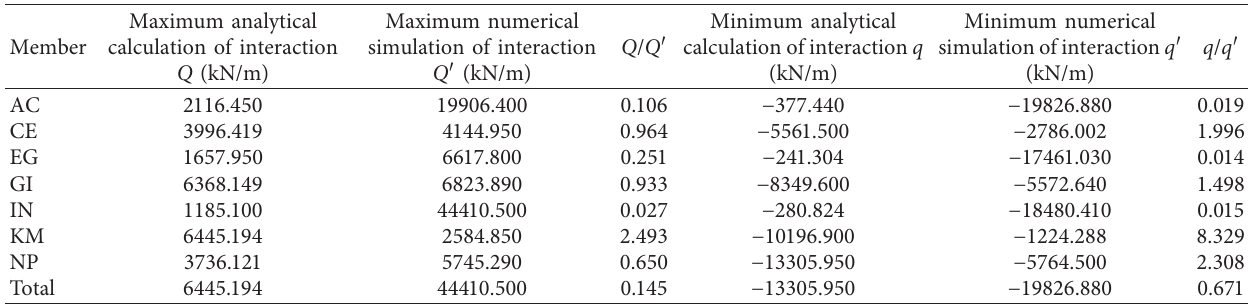
Table 8: A comparative table of the interaction between the antislide members and geotechnical